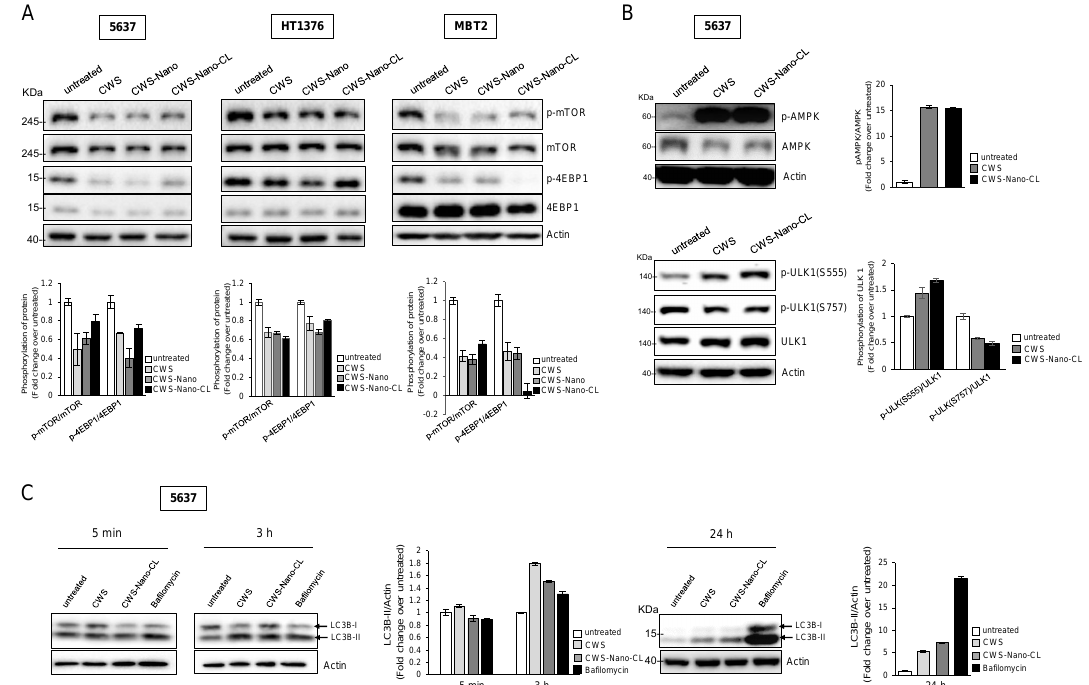
Figure 3. Induction of autophagy initiation by CWS-loaded formulations via mTOR signaling inhibition and AMPK activation in bladder cancer cells. ( A ) Cells were treated with 1 µ g / mL of CWS-loaded formulations for 24 h, and the lysates were subjected to Western blotting. ( B ) 5637 cells were treated with 1 µ g / mL of CWS or CWS-Nano-CL for 24 h, and then, the phosphorylated AMPK to total AMPK α protein expression ratio was assessed by Western blotting. As they are autophagy-initiation-related proteins, the ratio of phosphorylated ULK1 (Ser555 and Ser757) to total ULK protein expression was detected by Western blotting. ( C ) Cells were treated with 1 µ g / mL of CWS, CWS-Nano-CL, or 0.1 µ M bafilomycin (Bafilo) for 5 min, 3 h, or 24 h, and the cell lysates were subjected to Western blot analysis using anti-LC3B-I / II antibodies. Actin was used the loading control. The blots are representative of three independent experiments. The quantification graphs represent p-mTOR / mTOR, p-4EBP1 / 4EBP1, p-AMPK / AMPK, pULK1(Ser555) / ULK1, pULK1(Ser757) / ULK1, and LC3B-II / Actin ratios determined by densitometric analyses. All expression ratios were normalized to the untreated